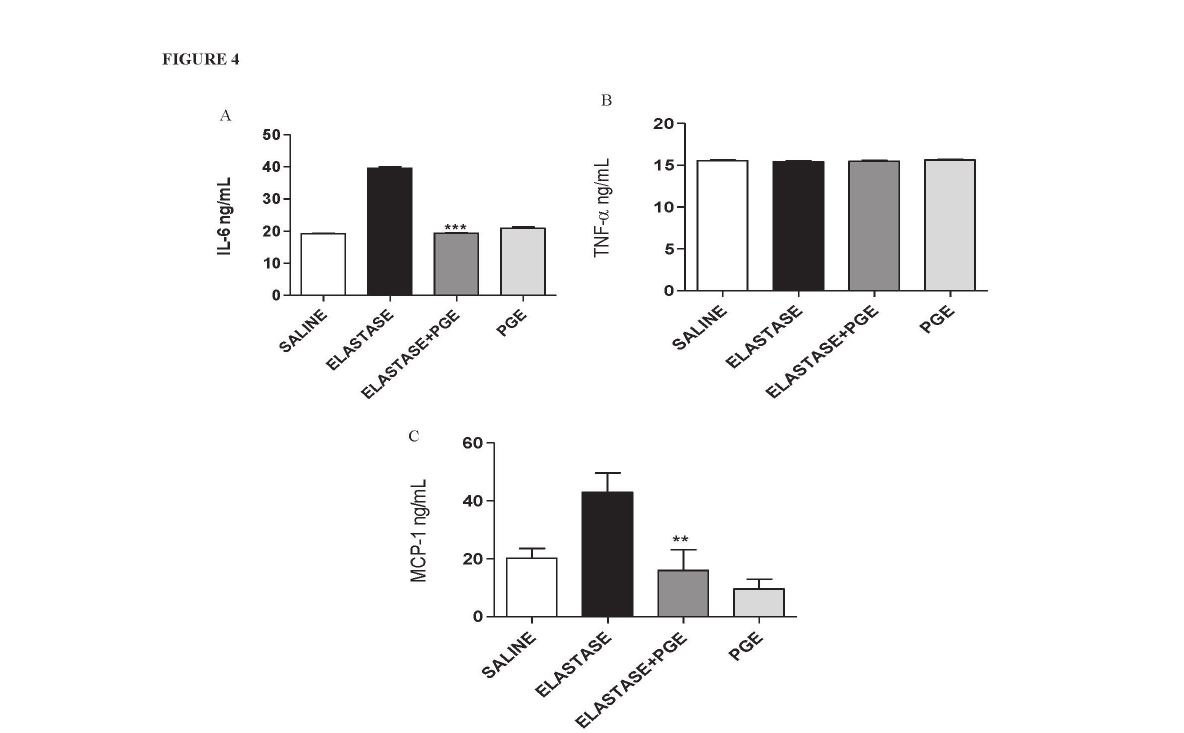
FIGURE 4 – Effect of PGE on BAL activity of TNF- α (A), IL-6 (B) and MCP-1 (C), 7 days after saline or Elastase instillation (D9). **: p < 0.01 vs Elastase. *: p < 0.05 vs Elastase.